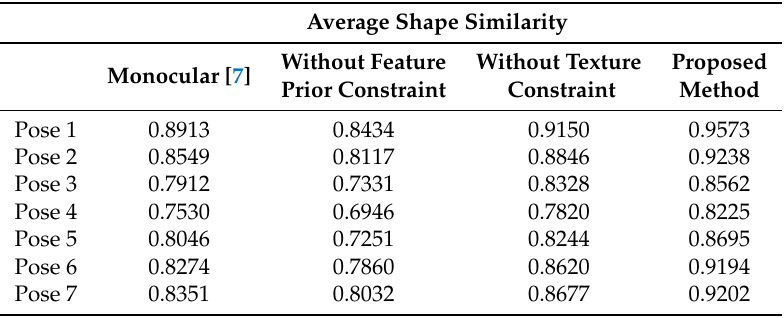
Table 3. The average shape similarity of 100 subjects under each pose using different methods.